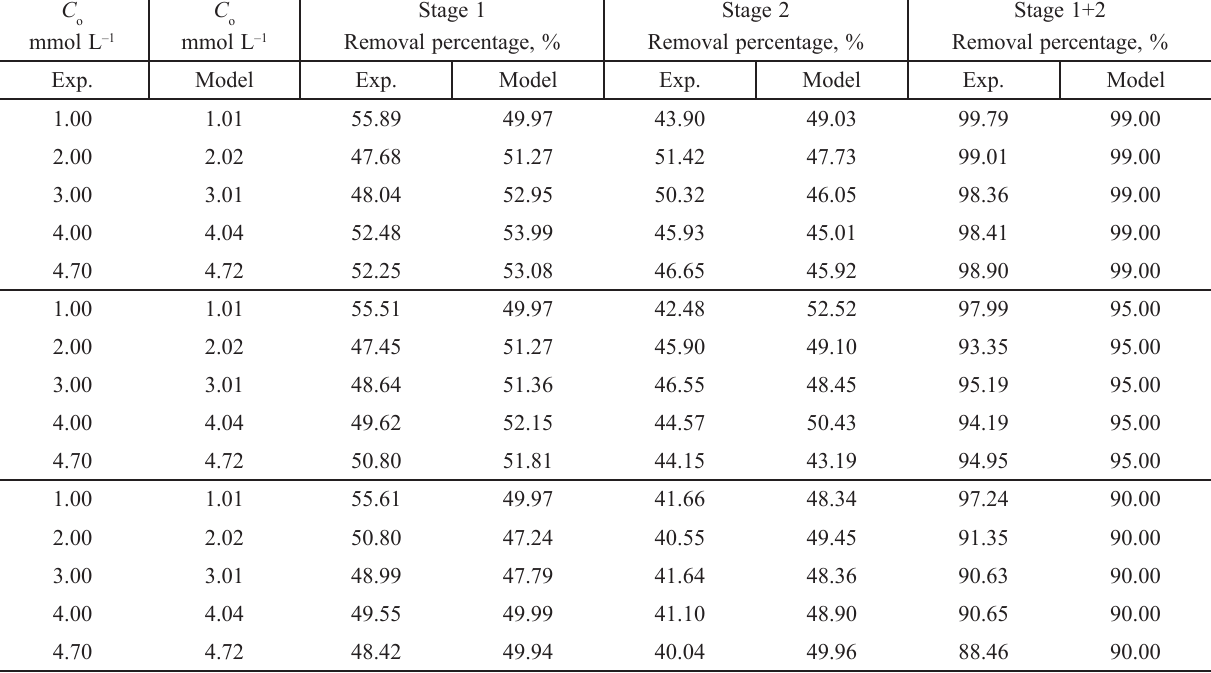
Table 5 – Comparison of experimental and calculated values of removal efficiency obtained in stage 1 and stage 2 for different initial concentrations and removal percentages for zinc C o mmol L